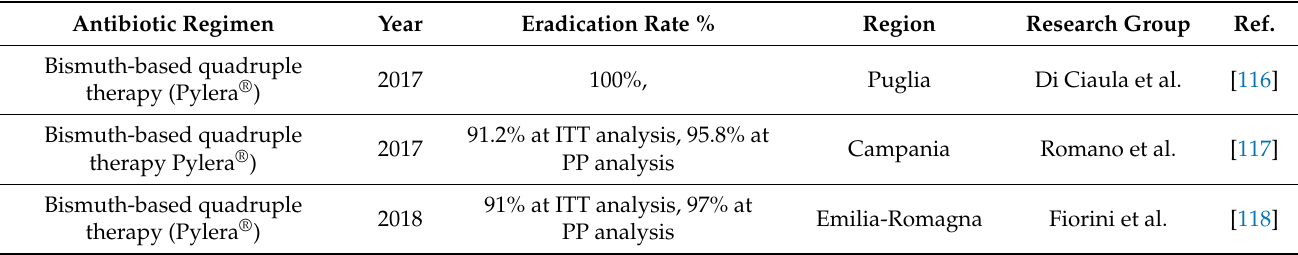
Table 10. Eradication Rate of bismuth-based regimens in treatment naïve